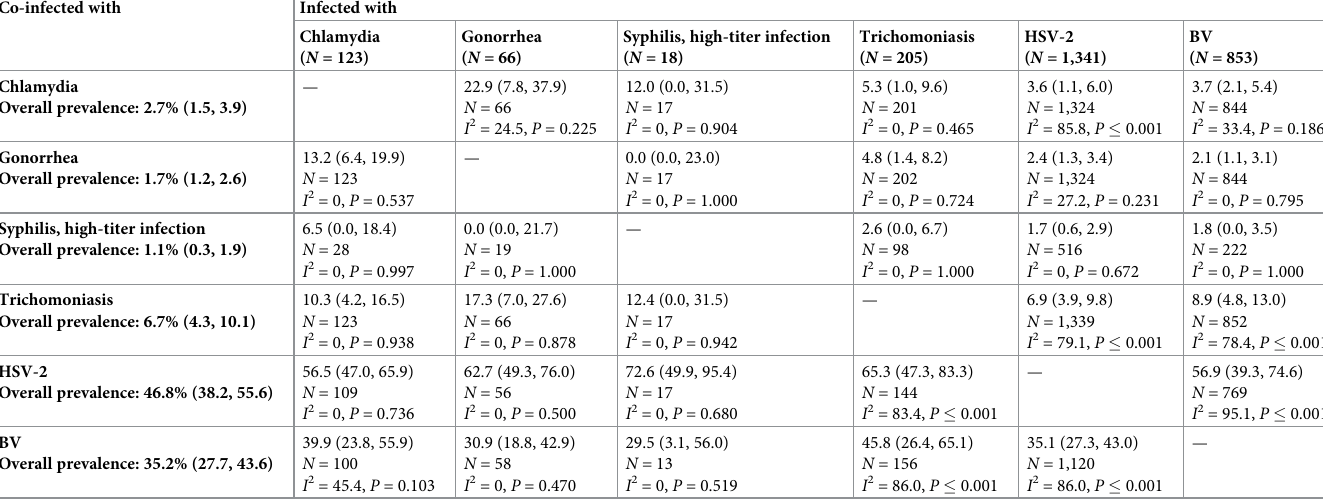
Data are presented as percent (95% CI) infected with the column infection who are co-infected with the row infection. N is the number of participants who were infected with the column infection and were also tested for the row infection; includes data from studies where at least 80% of all participants or at least 80% of a randomly selected sample of enrolled participants were tested for both infections.